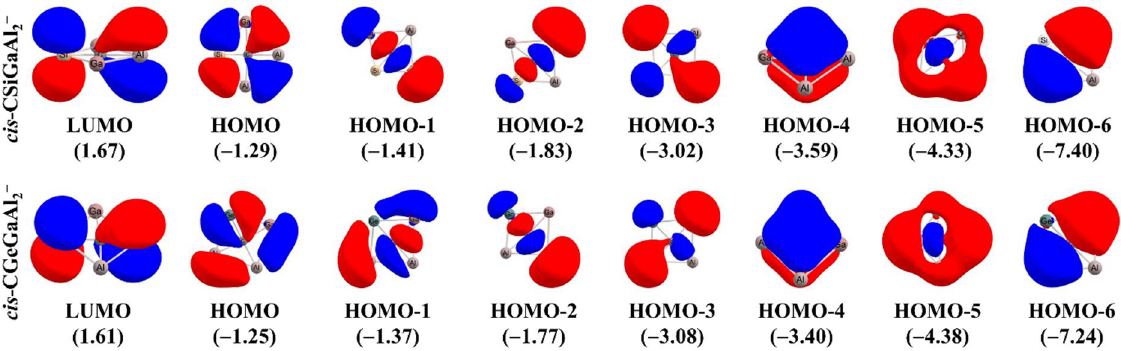
Figure 7. Plots of the molecular orbitals of the global minimum structures of CSiGaAl 2− and CGeGaAl 2− clusters. The values in the parentheses are the energies of the corresponding orbitals in the eV unit at the PBE0-D3/def2-TZVPP method.